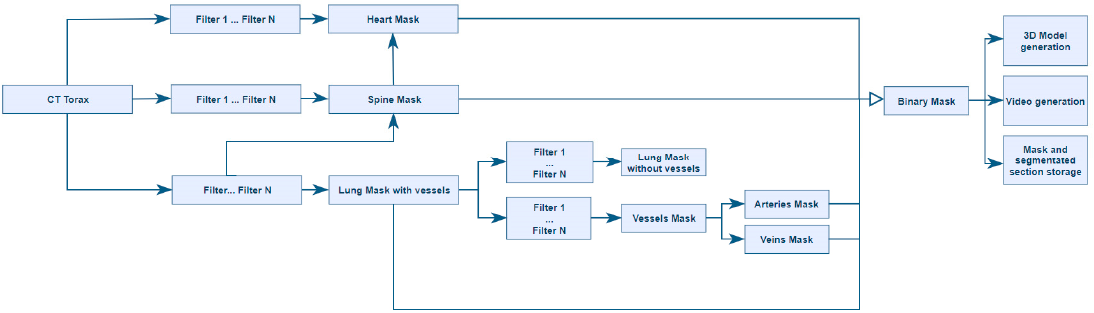
Figure 1. Tree of the different segmentation techniques.